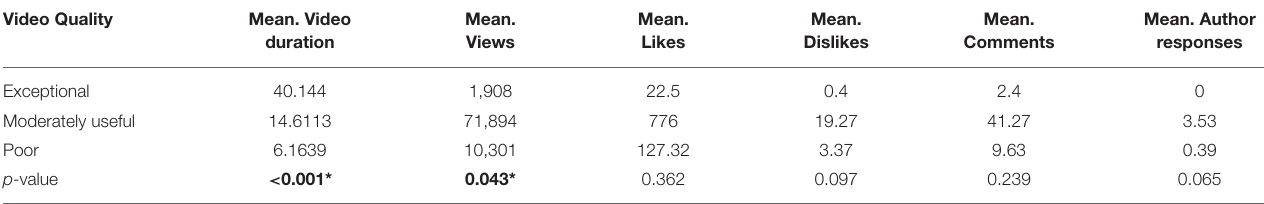
TABLE 6 | Objective data values categorized by video quality on YouTube. Video